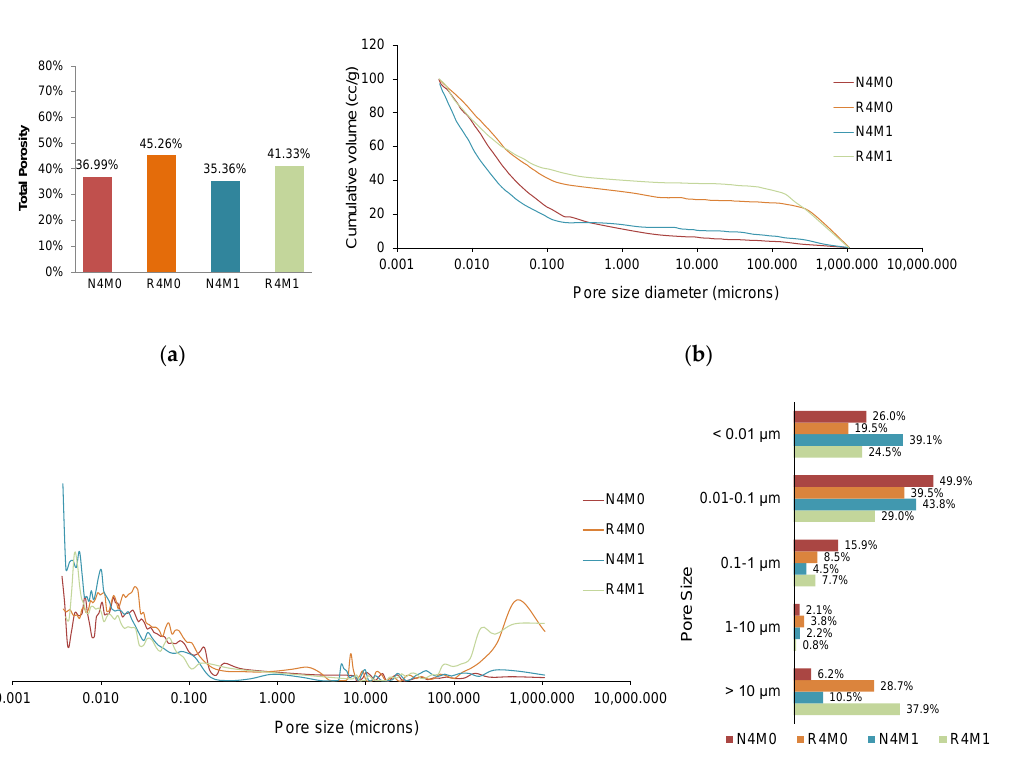
Figure 13. ImageJ analysis of bitumen content of the RAP grains. Figure 14 shows the images obtained for sample N4M0. From the sawed sample (Fig- ure 14a), it is possible to observe the aggregate clusters and note the large quantities of bitumen adhered to the grains, while other sections show only the bitumen with little to